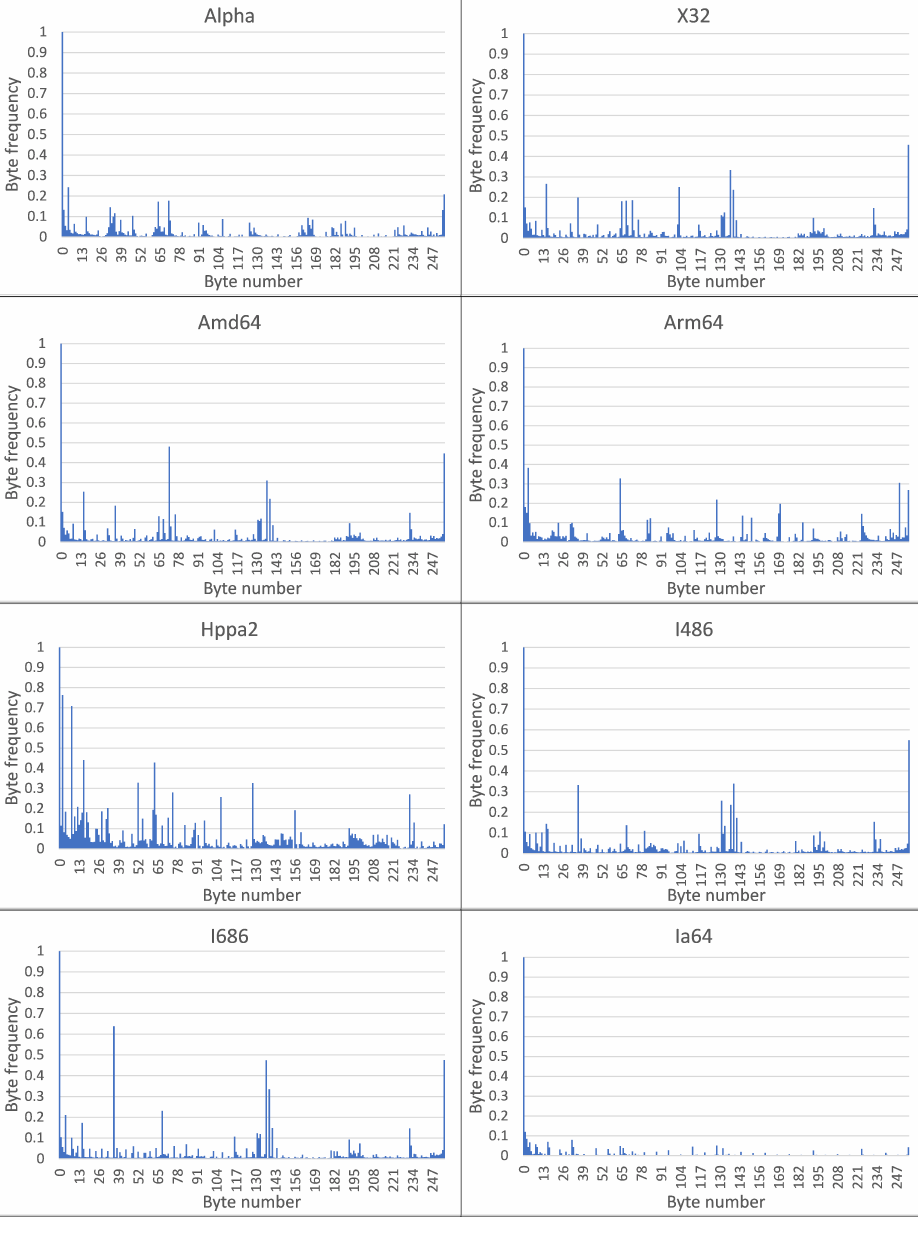
Figure 2. Byte-frequency signatures of MC classes for Top-16 CPDoSH Architectures (for Alpha, X32, Amd64, Arm64, Hppa64, I486, I686 and